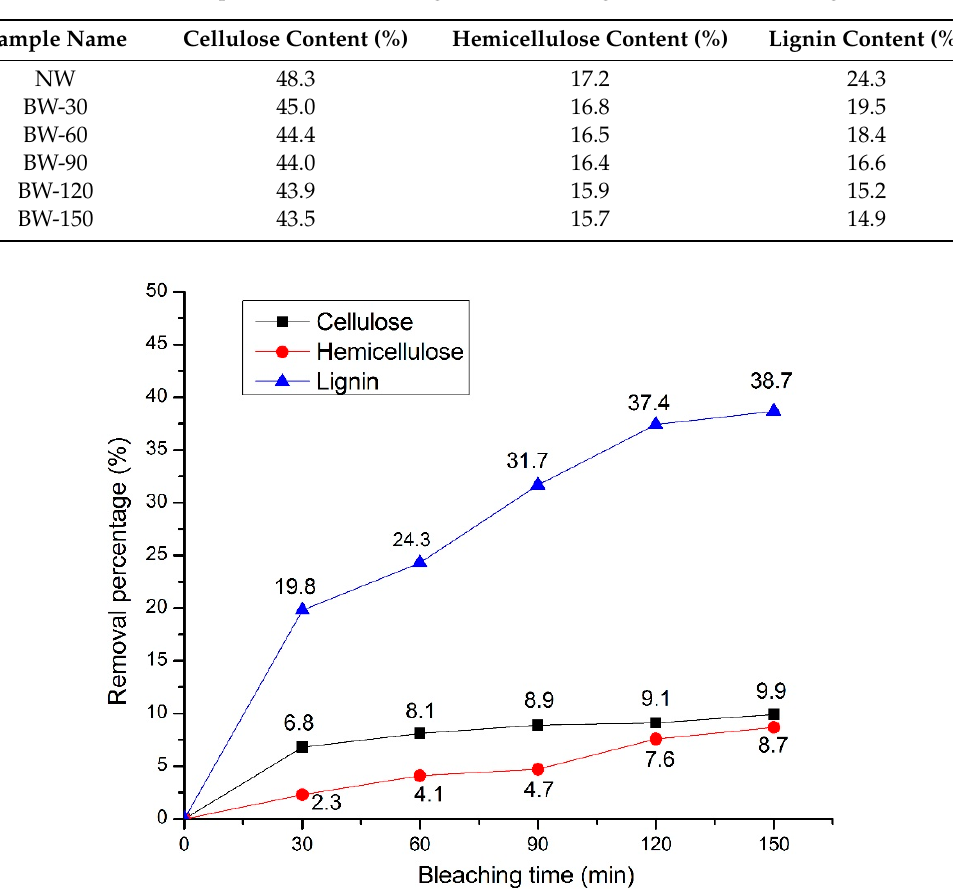
Figure 2. The removal percentage of cellulose, hemicellulose and lignin in wood samples at increasing H 2 O 2 bleaching times. 201